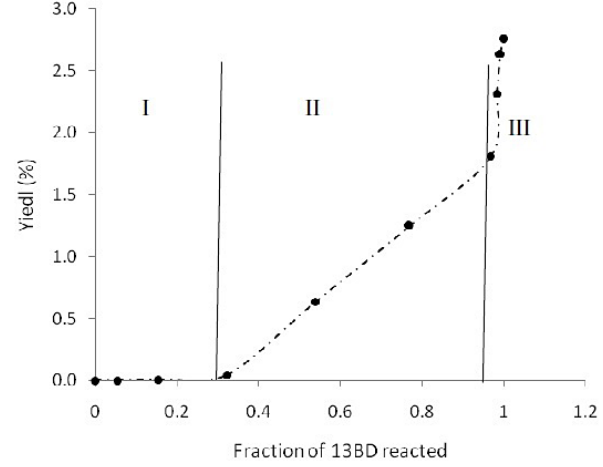
Figure 6. SOA yield as a function of the fraction of 13BD reacted (experiment